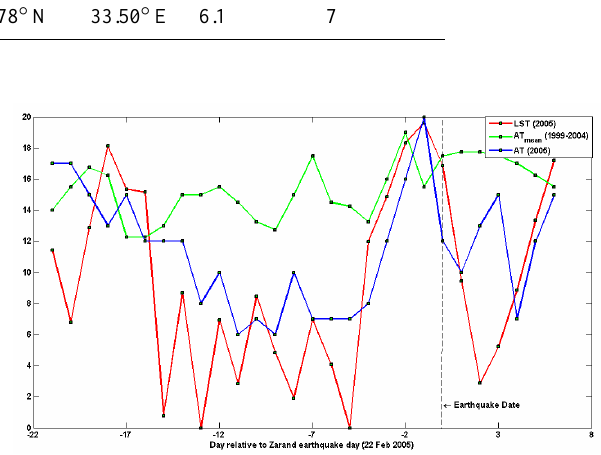
Fig. 2. Results of LST and AT data analysis for the Zarand earth- quake (22 February 2005) from 1 to 28 February 2005. The mean Figure 2. Results of LST and AT data analysis for the Zarand earthquake (22 February 2005) 3 of AT during the period of 01 to 28 February from 1999 to 2004 is from 01 to 28 February 2005. The mean of AT during the period of 01 to 28 February from 1999 4 represented as a green curve. to 2004 is represented as green curve. 5